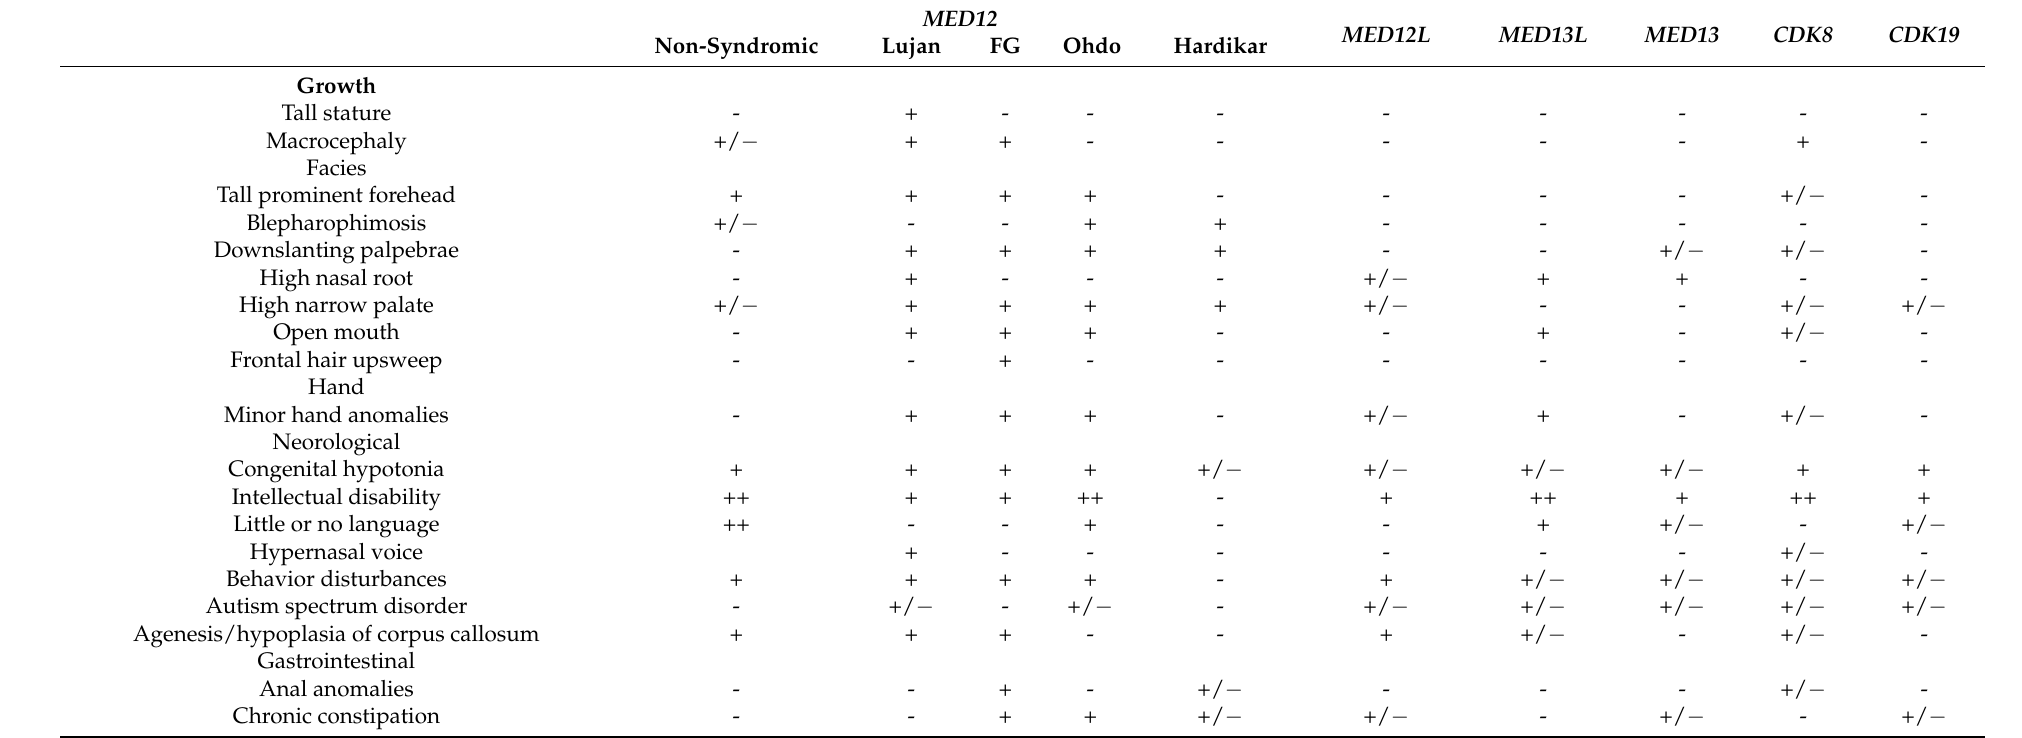
Table 1. Comparison of phenotypes found in the kinase module genes. Intellectual disability was classified as mainly mild to moderate (+) or mainly moderate to severe (++). Other signs were considered as very frequent (+), occasional (+/ − ), or absent/rare ( − ). Lujan: Lujan-Fryns syndrome. FG: Opitz-Kaveggia (FG) syndrome. Ohdo: Ohdo Syndrome–Maat-Kievit- Brunner Type. This table was adapted from Nizon et al. 2019 [10], and supplemented with data from Calpena et al. 2019 [49] (CDK8), Chung et al. 2020 [5] (CDK19), and Li et al. [16] (Hardikar